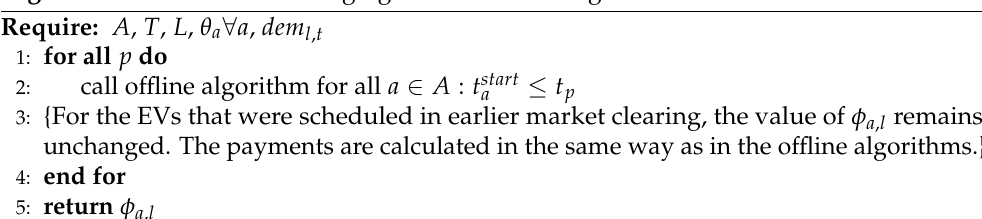
Figure 1. Online EV to charging station scheduling. Algorithm 1 Online EV-to-charging-station